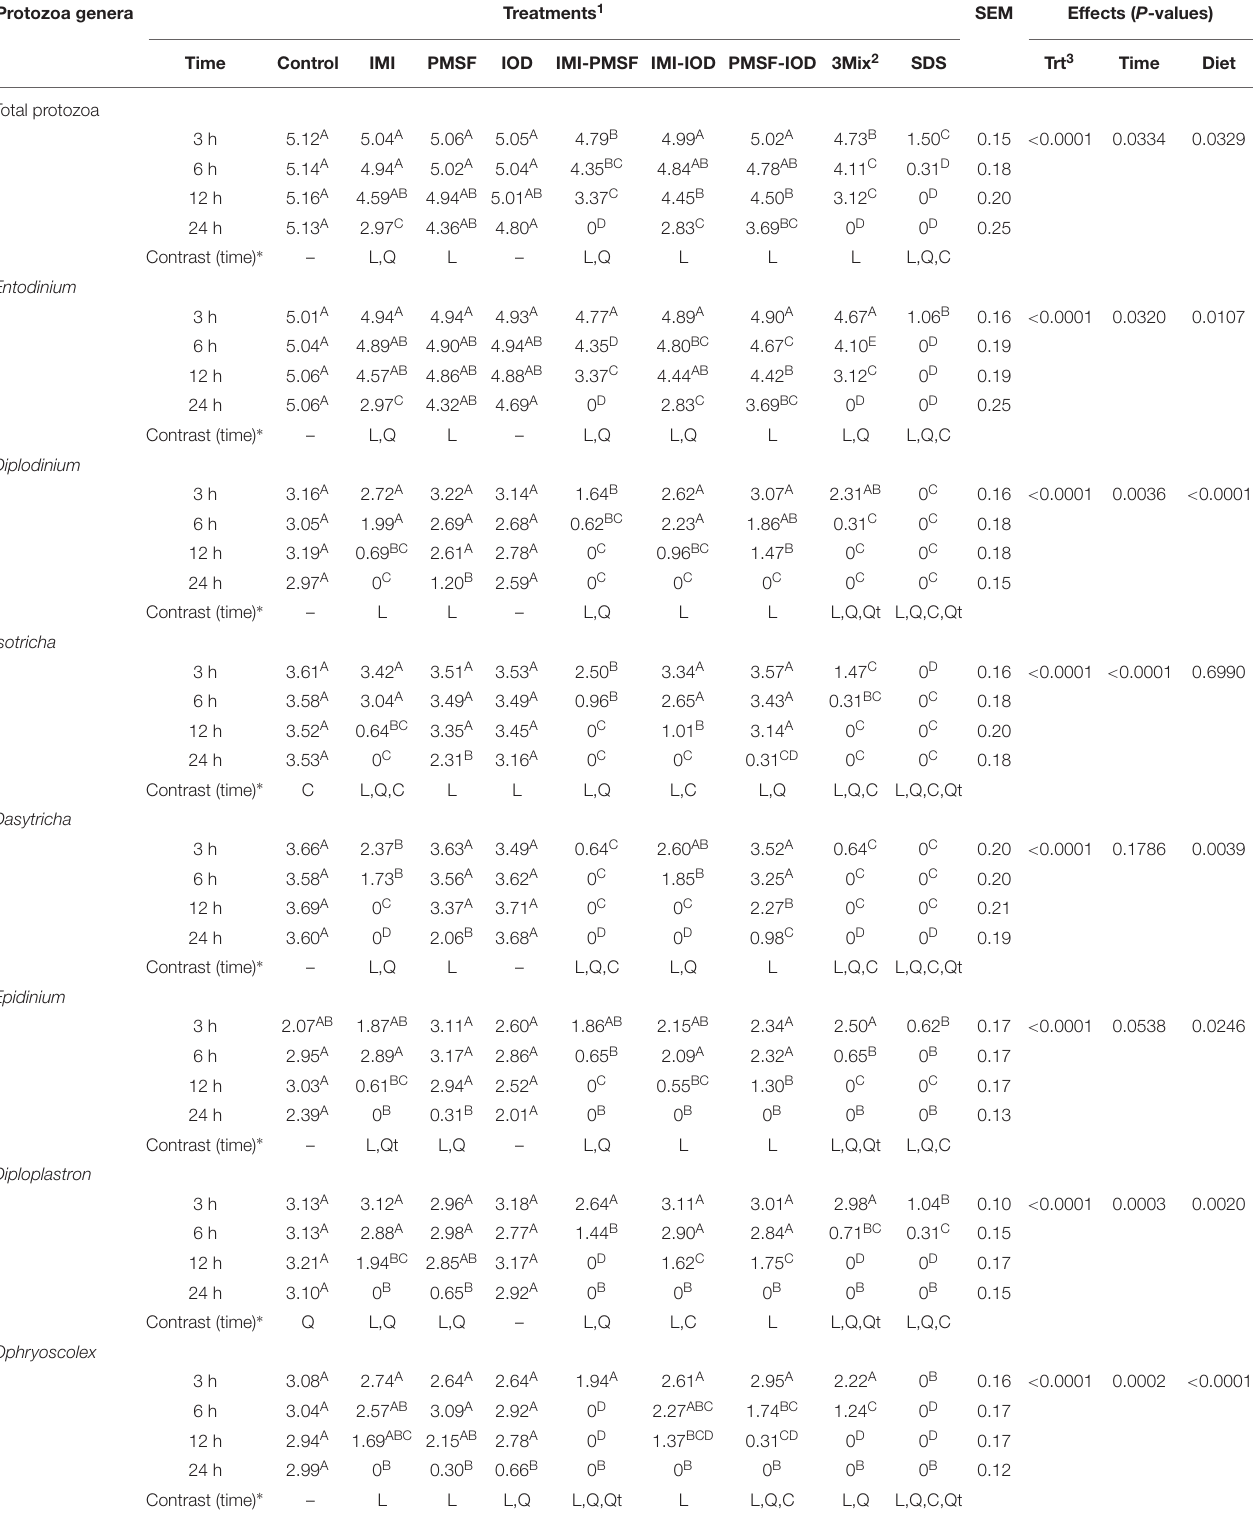
TABLE 1 | Inhibition of the identified protozoal genera (log-transformed counts) by the inhibitors (at 3, 6, 12, and 24 h of incubation). Protozoa genera Treatments 1 SEM Effects ( P